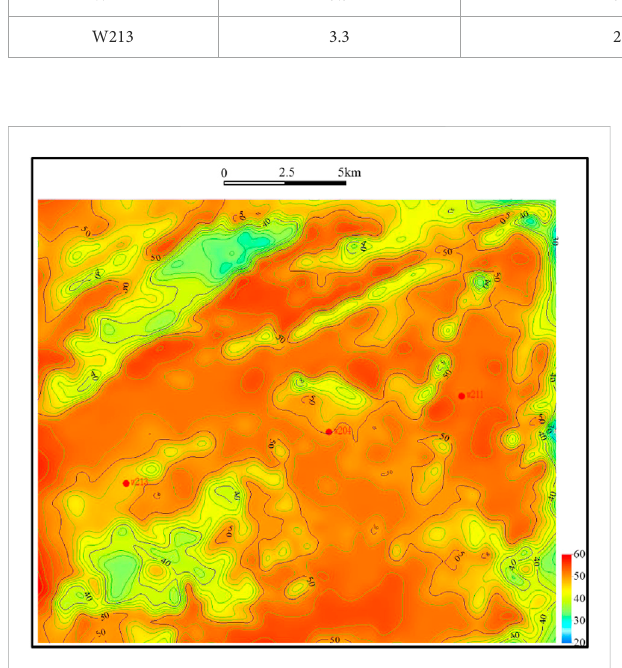
FIGURE 8 Planar distribution map of high-quality shale thickness in the W204 well area (m).